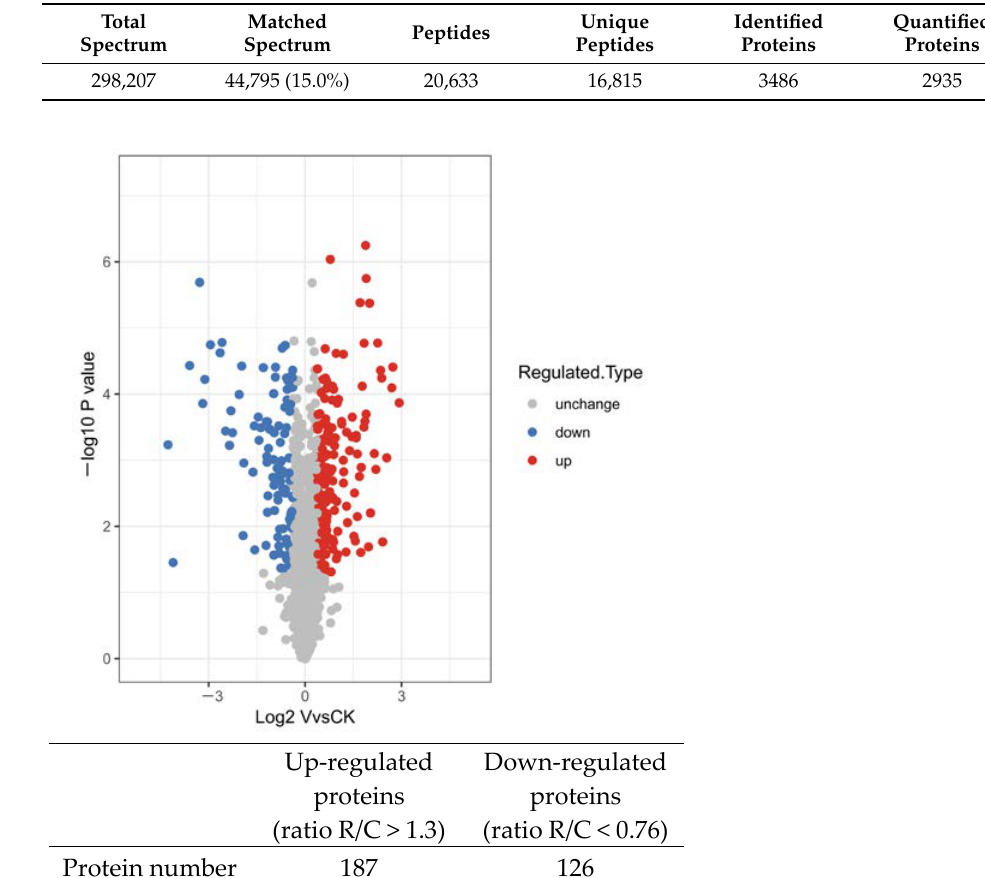
Table 1. Summary of MS/MS spectrum database search analysis.